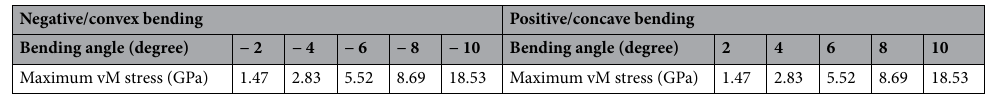
Table 2. Bending angle in degrees with maximum vM stress in GPa for proposed